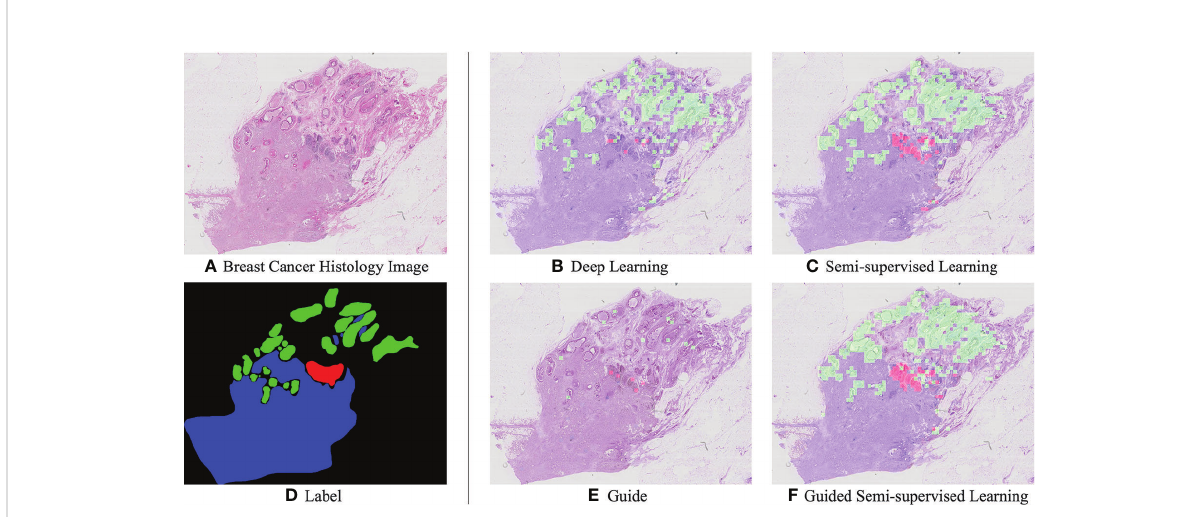
FIGURE 4 Example histological images of breast cancer (A) and corresponding manully label (D) . Results of breast cancer analysis: A visual comparison of the supervised ResNet-101 model (B) and the semi supervised method (C) . In particular, (E) is to randomly select some tiles from WSI images as marking data, that is, to simulate pathologists to mark typical areas. (F) is the result of interactive guided semi-supervised learning.